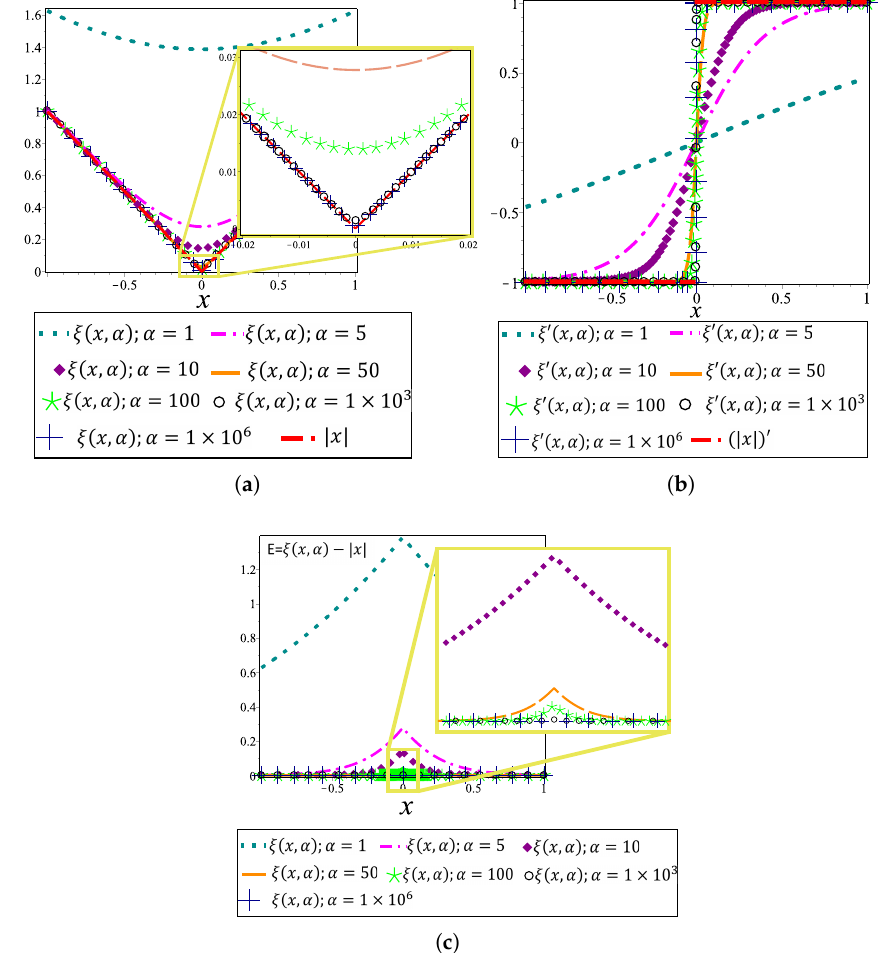
Figure 7. Approximation of absolute value function. ( a ) Approximation of absolute value function. ( b ) First derivation of the approximation of the absolute value function. ( c ) Error (E) between the approximation of absolute value function and | x |